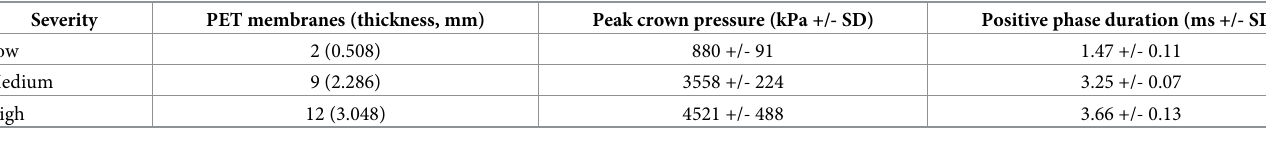
Table 4. Severity bins for bare head blasting conditions.